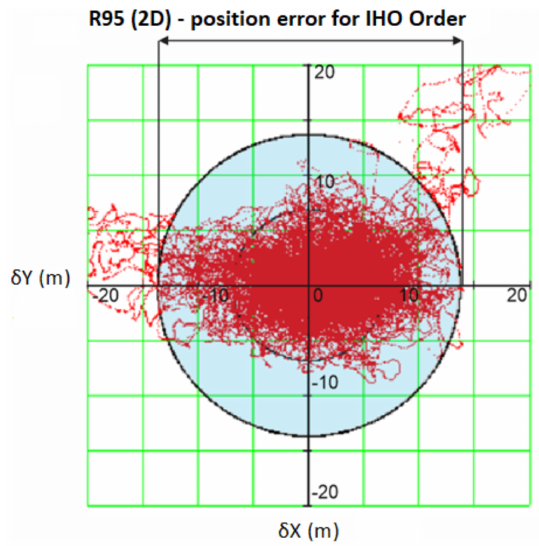
Figure 4. An example of geometric interpretation of the availability required for IHO order